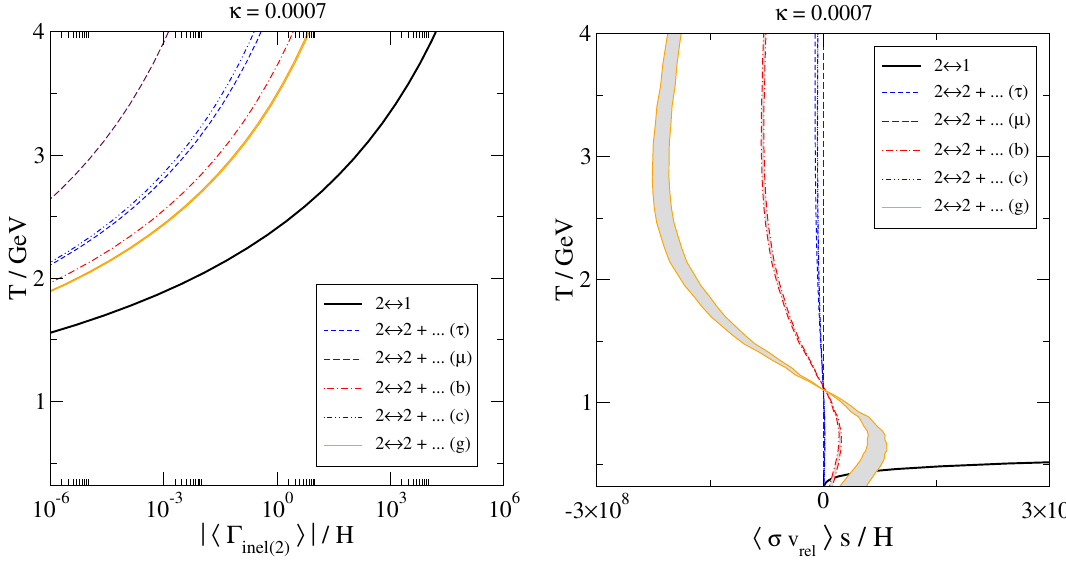
Figure 2 . Left: the absolute value of the momentum-averaged chemical equilibration rate from eq. (2.21), separated into contributions from different channels, with “ + . . . ” indicating virtual corrections. Freeze-out starts when h Γ i ∼ H , and in this regime NLO corrections are suppressed inel( 2 ) by orders of magnitude with respect to the 2 ↔ 1 channel. Right: the coefficient h σv i from rel eq. (2.23), normalized as it appears in eq. (4.2) (the factor 3 c 2 ' 1 has been omitted here, though s